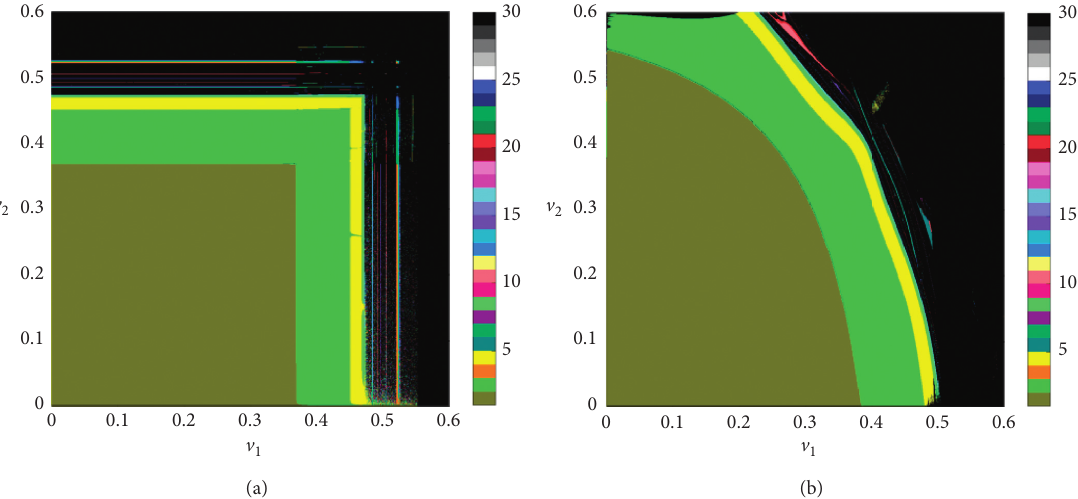
Figure 1: The 2-D bifurcation diagrams about v � 0 . 002, and α � 0 . 995; (b) a � 6 . 5, b � 1 . 2, c � 0 . 5, α α 1 2